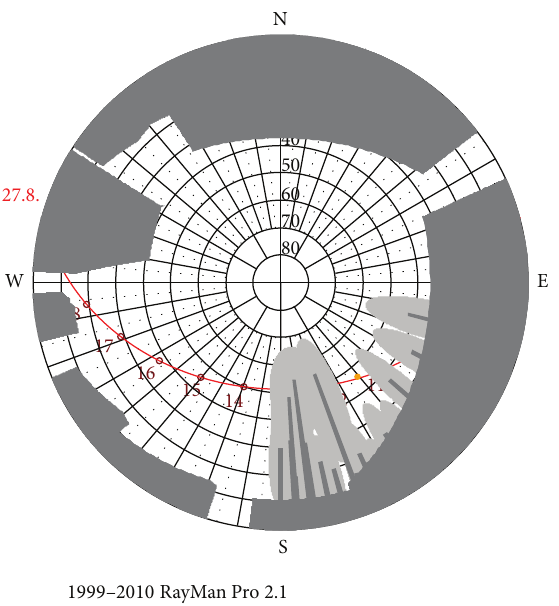
Figure 9: Polar diagram for the sky view factor (zone 1) in